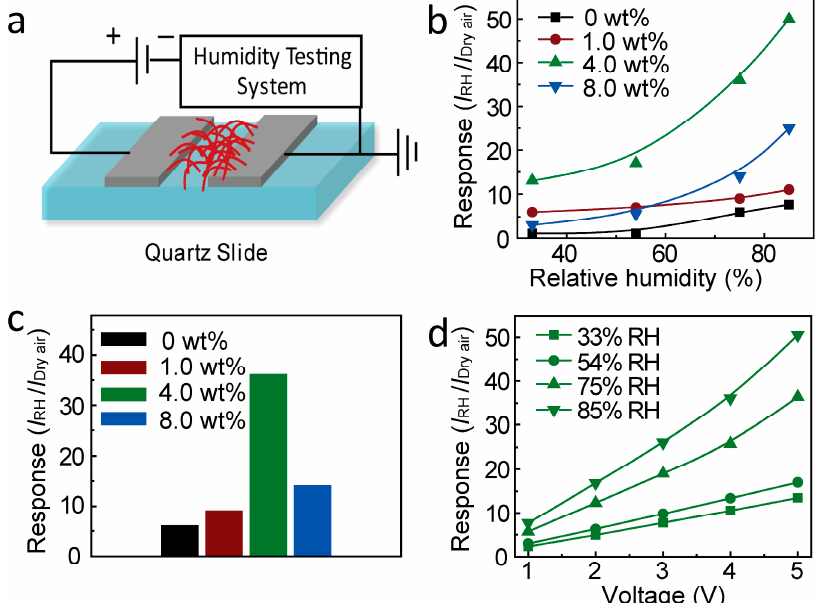
Figure 3. ( a ) Schematic illustration of the SnO 2 porous nanofiber-based sensor; ( b ) the response vs. the relative humidity (RH) of different doping levels of Li + -doped SnO 2 porous nanofibers at 5 V under room temperature; ( c ) the response comparison of different Li + -doped SnO 2 porous nanofibers under 75% relative humidity; ( d ) the response sensitivity–driving voltage properties for 4.0 wt % Li + -doped SnO 2 porous nanofiber sensors under various relative humidity levels.